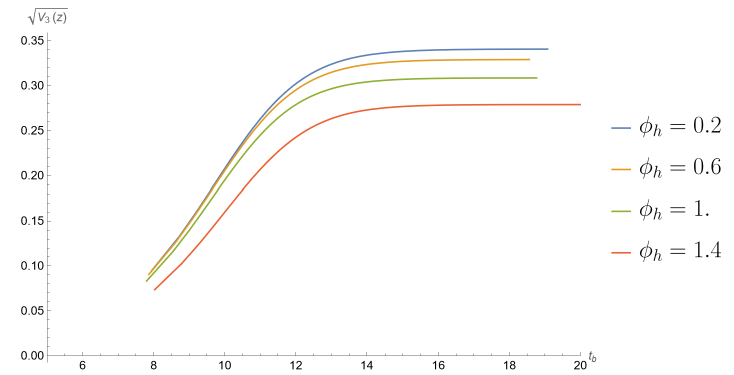
Figure 11 . Volume complexity rate as a function of time for a black hole with ρ = 2 , z h = 1 and q = 1